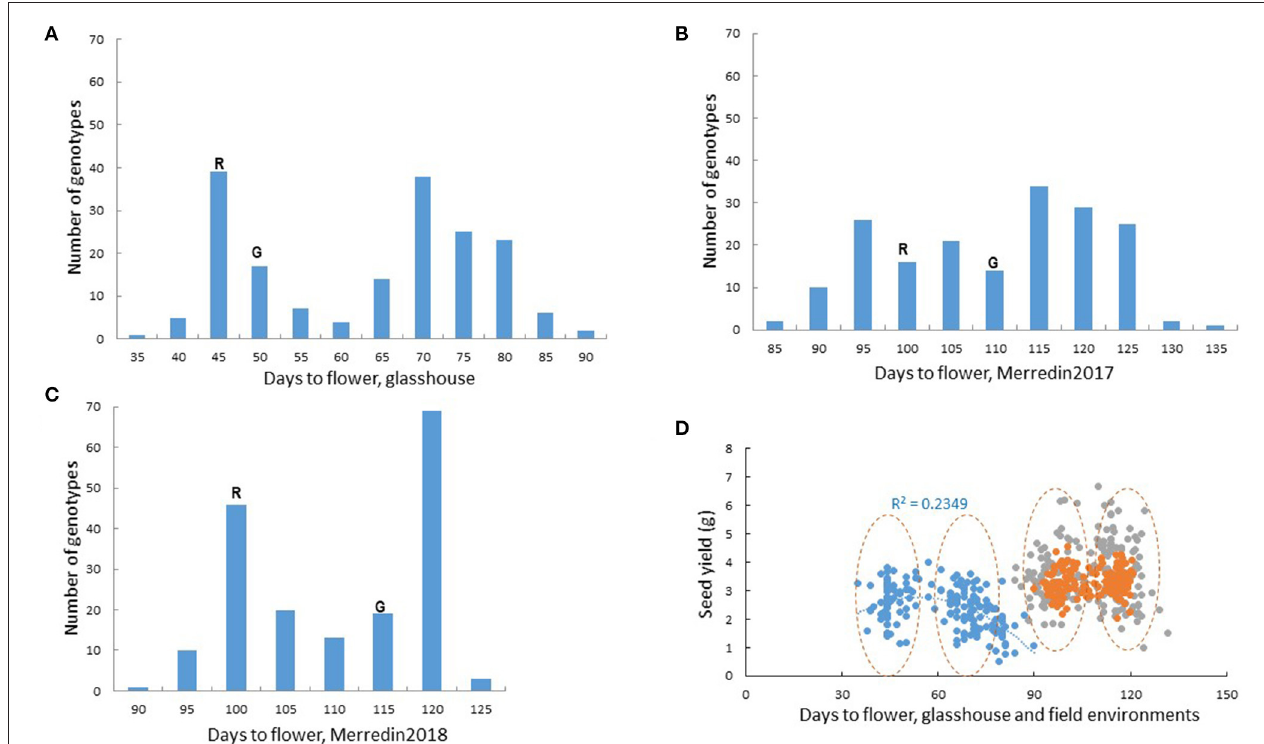
FIGURE 2 | Flowering in the Rupali/Genesis836 RIL mapping population. Bimodal distribution for flowering time in the RIL population in (A) the glasshouse (B) Merredin2017 and (C) Merredin2018. Days to flower for the parents, Rupali(R) and Genesis836(G) is indicated. Transgressive segregation for flowering was evident in all the environments. (D) Influence of flowering on seed yield in the glasshouse and two field environments under non-saline conditions. Blue dots represent glasshouse data, gray dots represent data from Merredin2017 and orange dots represent data from Merredin2018. Generally, genotypes clustered into “early” and “late” groups as indicated by the dashed circles. Very early and very late flowering genotypes in the glasshouse had lower yields compared to the rest of the lines, a phenomenon that was not observed in the field.